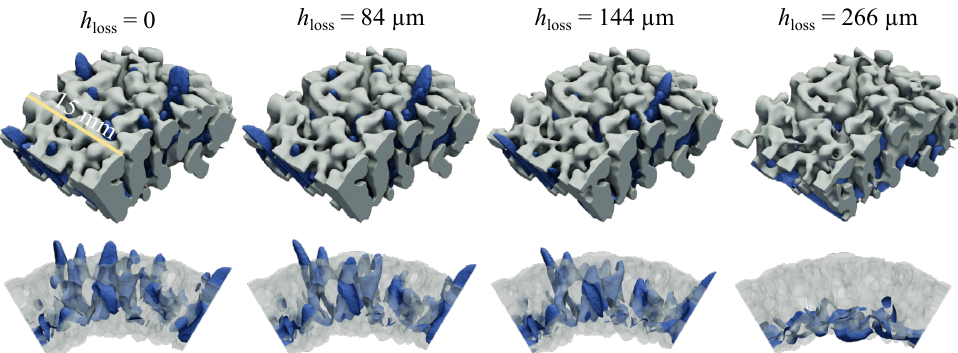
Figure 9. Flame front localization within porous media under the different thicknesses of eroded